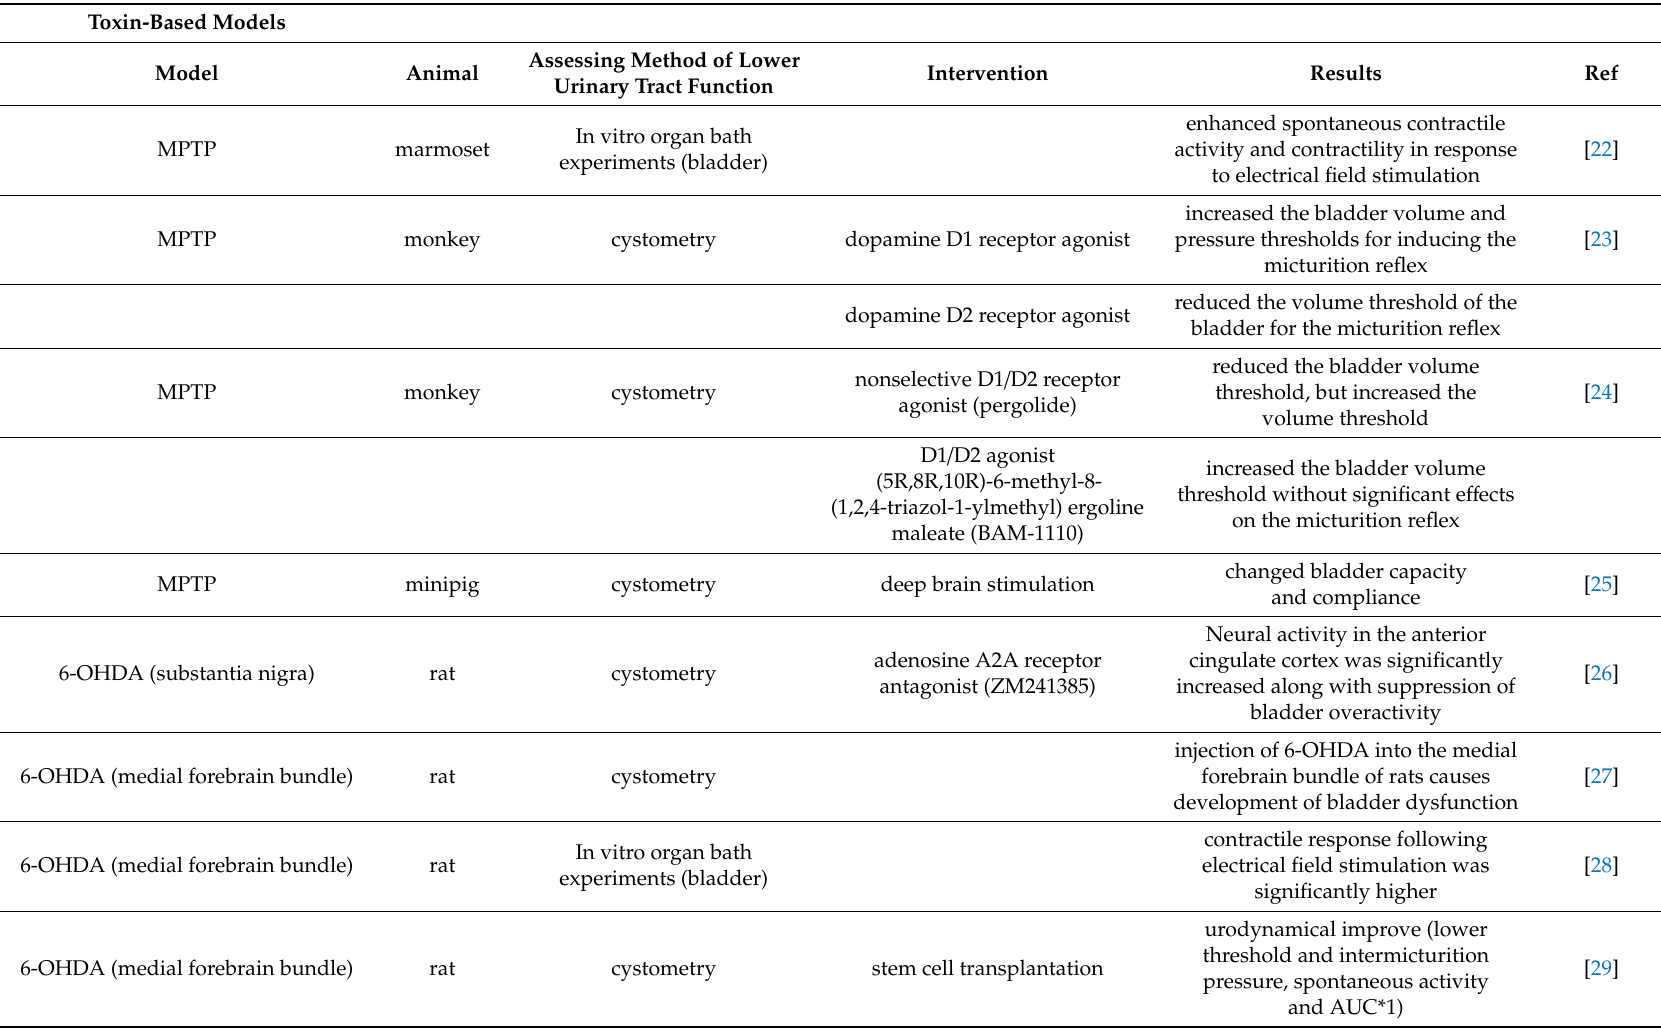
Table 1. Summary of animal models, assessment of the lower urinary tract function methods, intervention and results of Parkinson’s Disease (PD) research